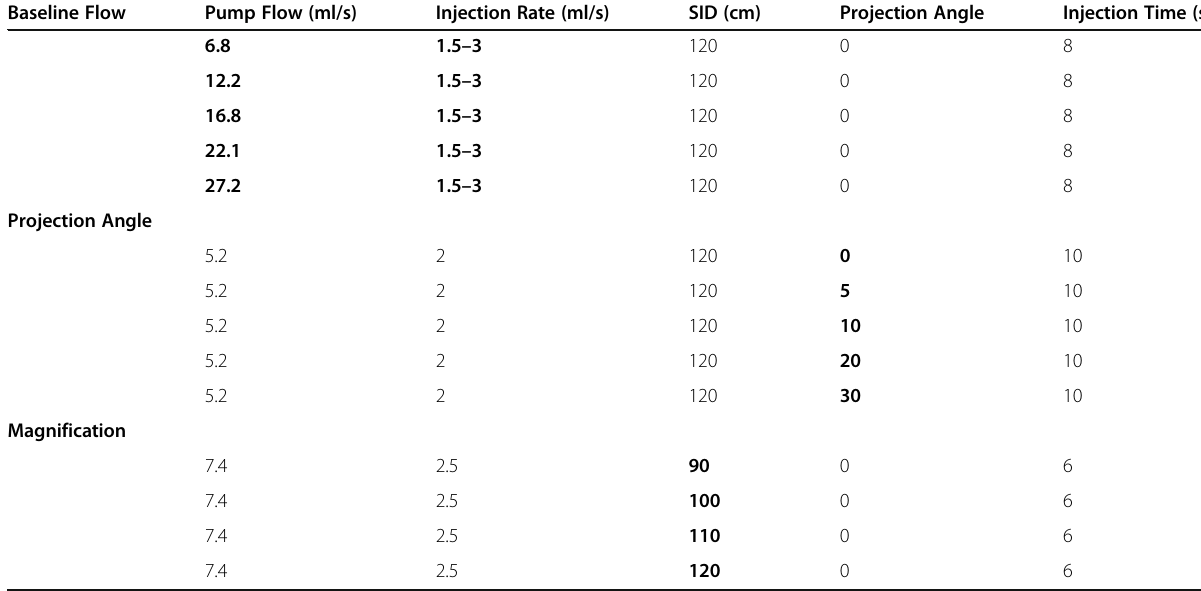
Table 1 In Vitro Imaging Parameters Baseline